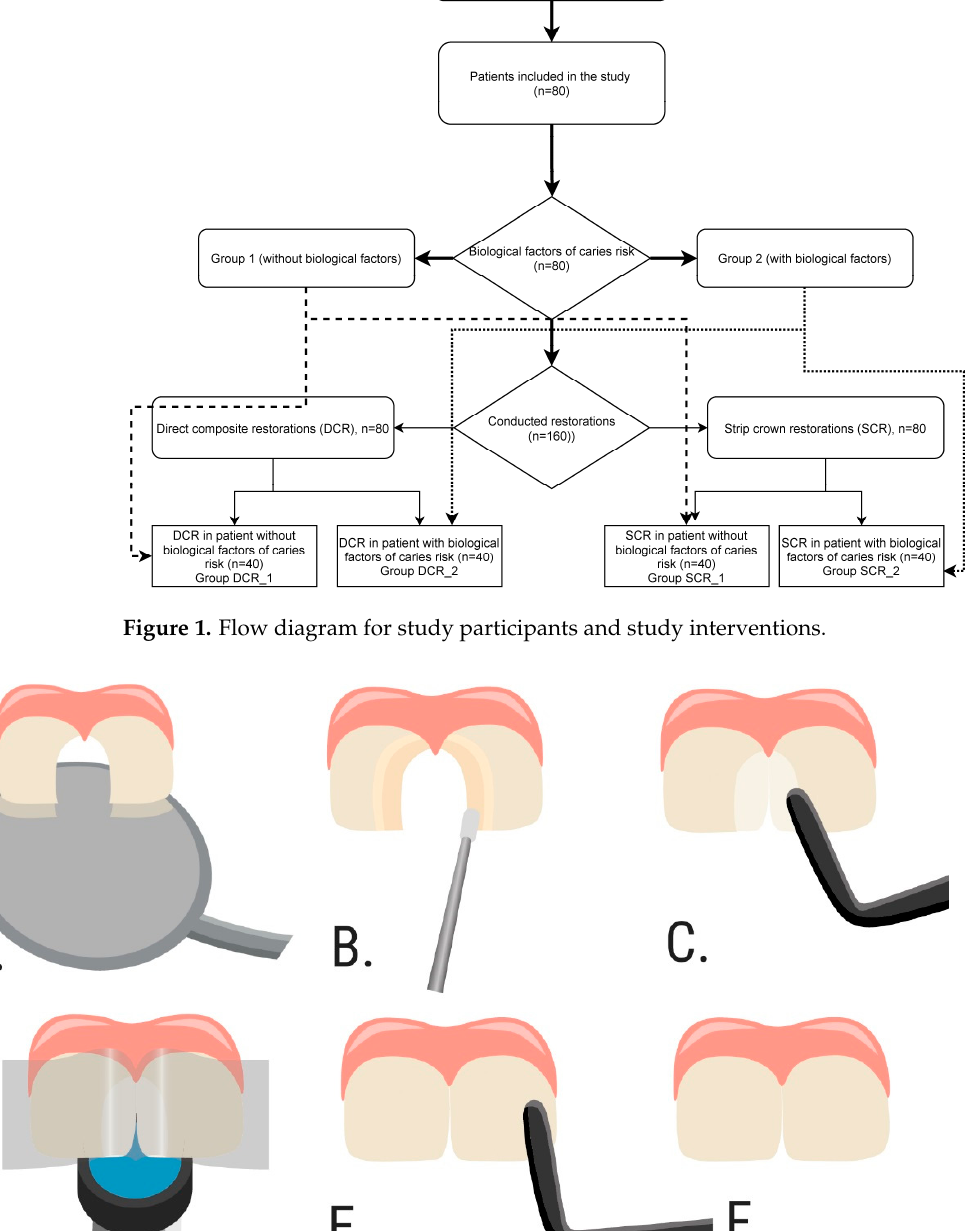
. Figure 3. Schematic layout of class IV cavities restoration with strip crowns and composite material. ( A ). Step 1—prepared class IV cavities on two central incisors, application of 37% phosphoric acid to the entire enamel surface (both vestibular and palatal). ( B ). Step 2—applying the adhesive system. ( C ). Step 3—choosing the appropriate size of strip crowns. ( D ). Step 4—prepared strip crowns (cut to a height). ( E ). Step 5—strip crowns are placed to the teeth. ( F ). Step 6—restored cavities at both central incisors (final result). The class IV cavities of DCR groups (DCR_1 and DCR_2) were restored with the in- cremental layering technique using the nano-ceramic composite ceram.x ® SphereTEC™